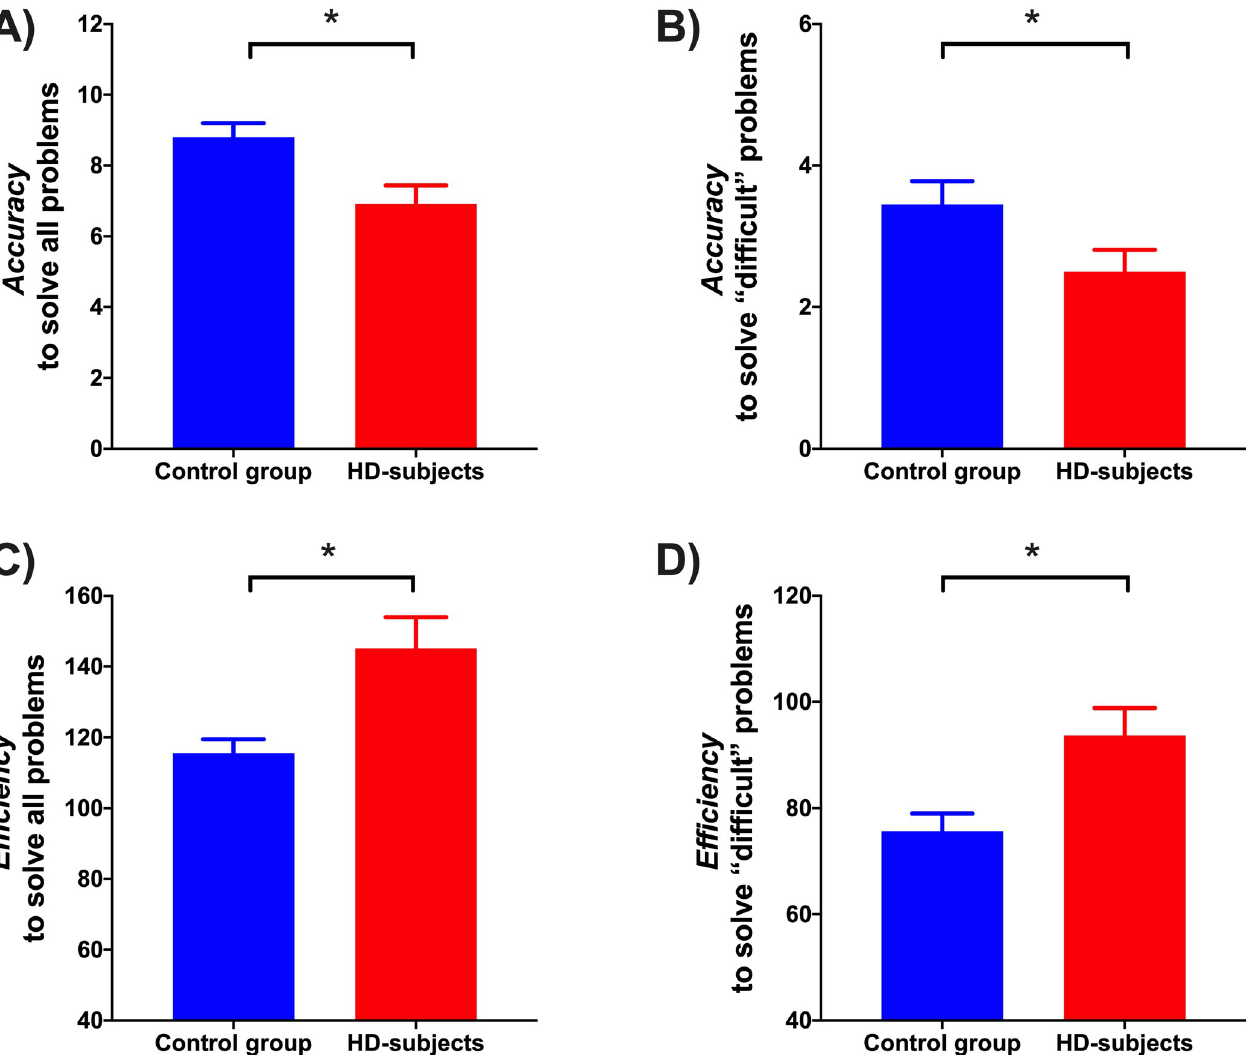
Fig 1. Differences in SOC scores analyses between groups. A) Accuracy to solve all problems: Number of problems solved in the minimum number of movements. B) Accuracy to solve "difficult" problems: Number of problems solved in the minimum number of movements. C) Efficiency to solve all problems: Sum of movements made to solve each of all problems. D) Efficiency to solve "difficult" problems: Sum of movements made to solve each “difficult” problem. � p <